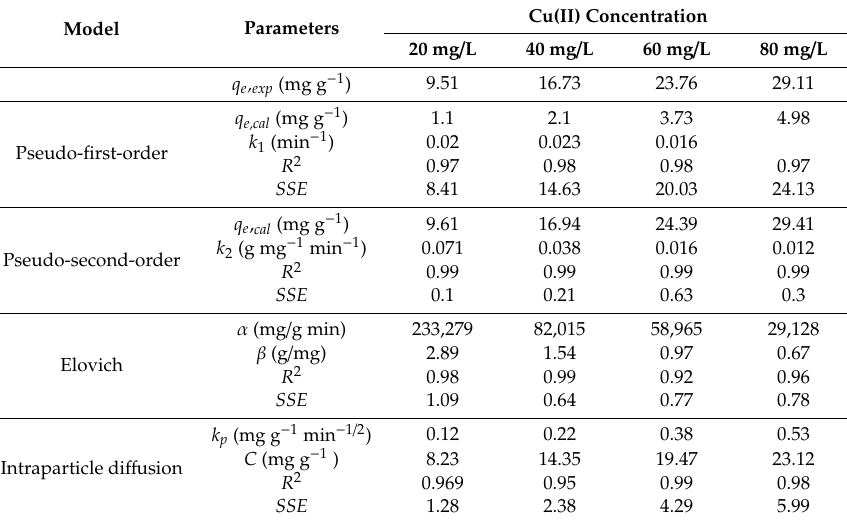
Table 2. Kinetics